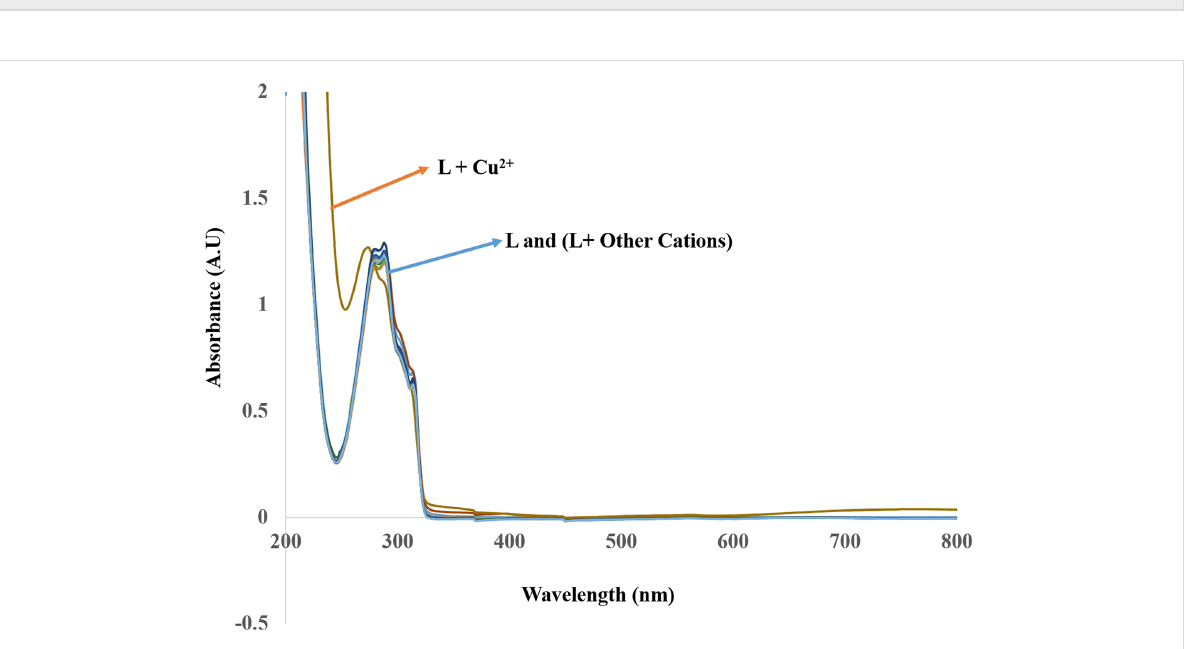
Figure 1: Absorption spectra of L (1.0 × 10 − 5 M) and its complexes with different metals (10 equiv) in